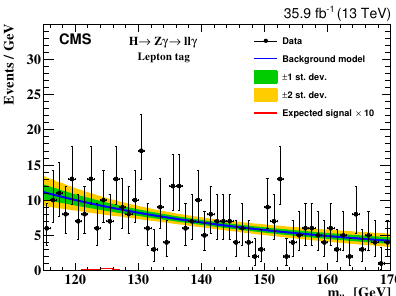
Figure 5 . Background model (cid:12)t to the m ‘‘(cid:13) distribution for H The green and yellow bands represent the 68 and 95% CL uncertainties in the (cid:12)t to the